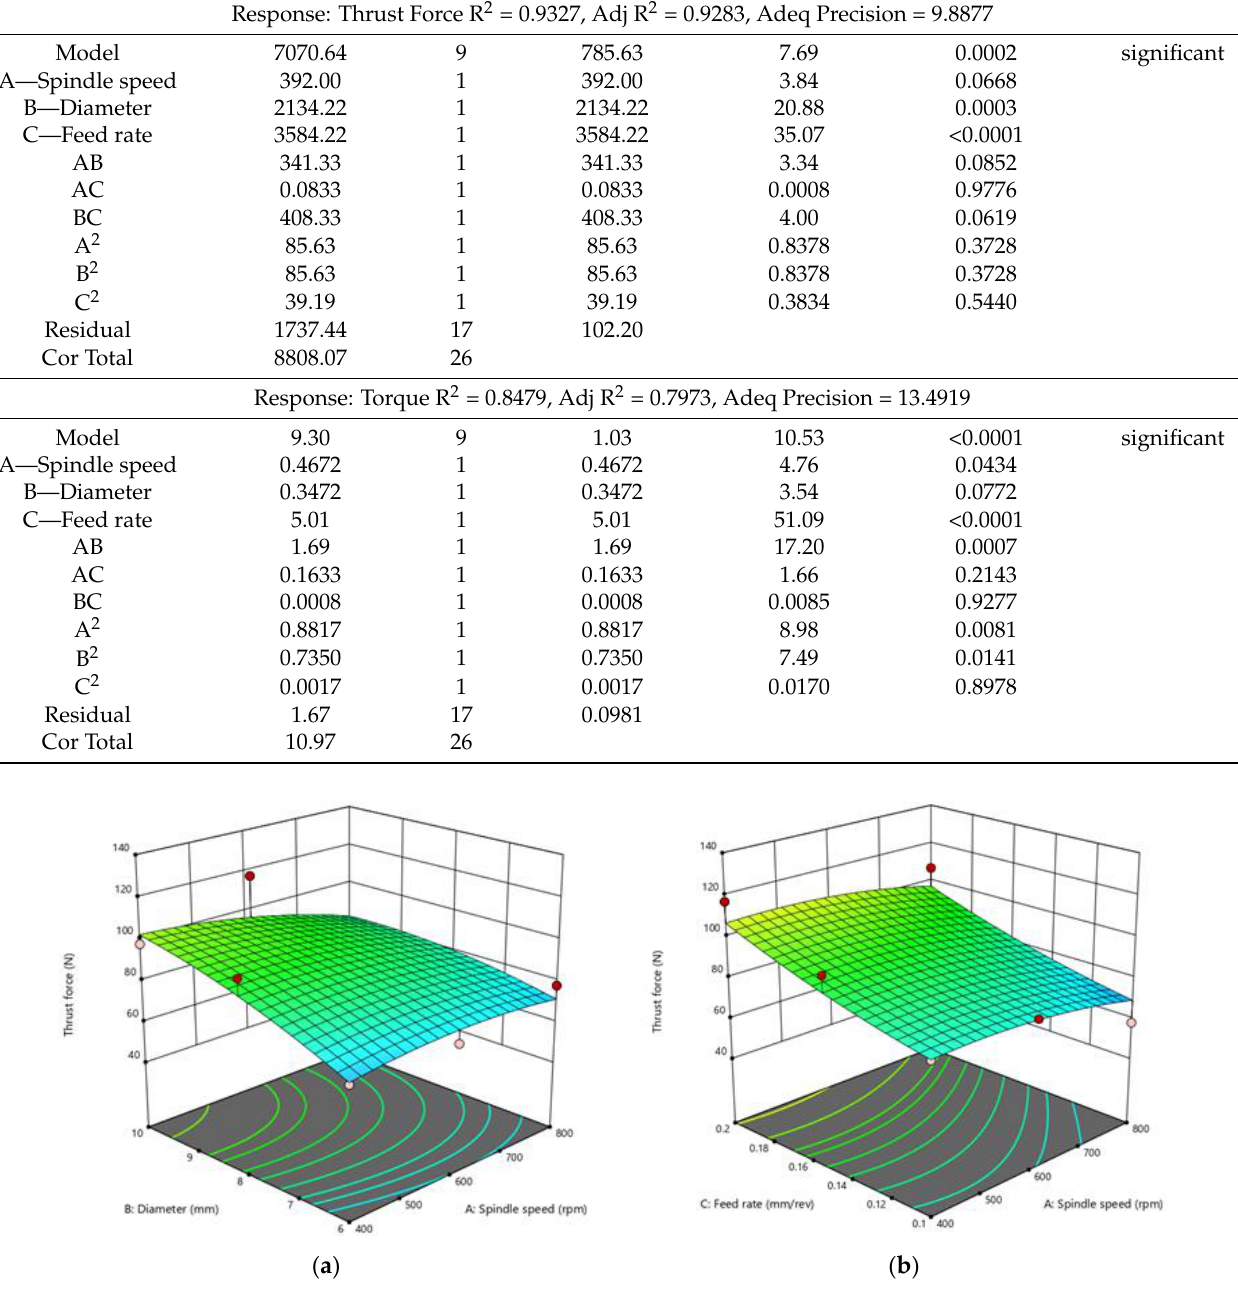
( d ) Figure 9. The 3D surface plots of the factors that effect thrust force, including the interactions be- tween spindle speed and diameter ( a ), feed rate and spindle speed ( b ), and feed and diameter ( c ). Actual vs. predicted thrust force ( d ).